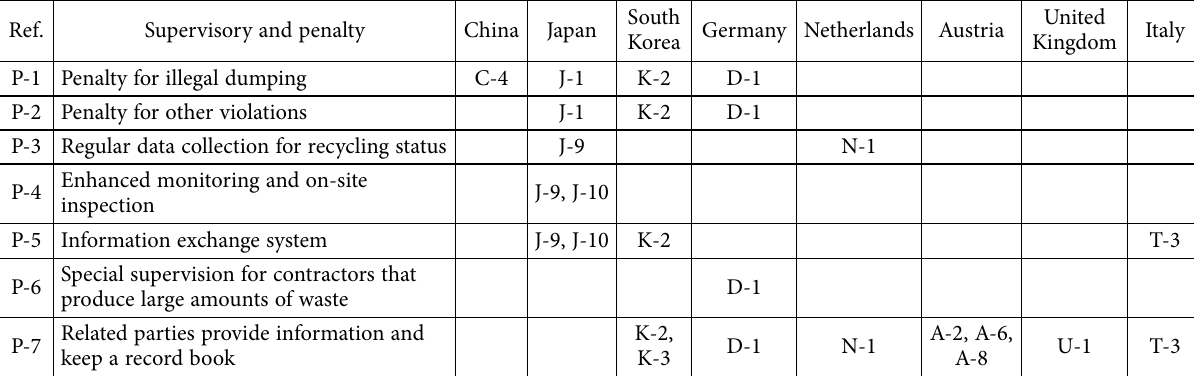
Table 14. Comparison on supervision and